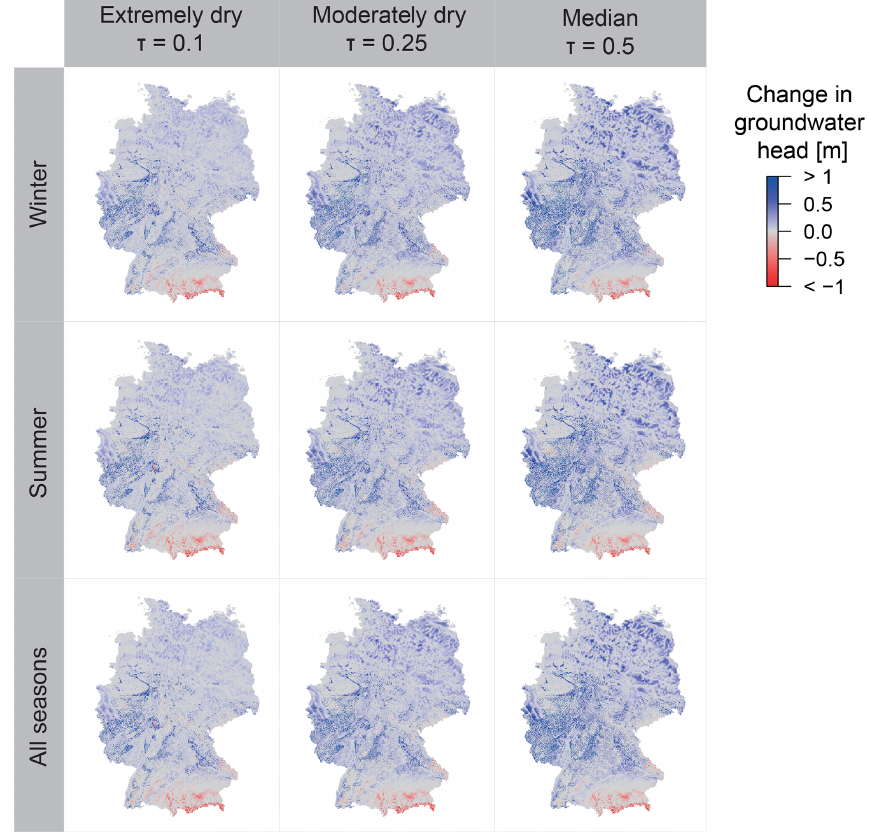
Figure 5. Groundwater head changes for S SHIFT in Germany for selected drought thresholds (columns) for different seasons (rows) for a shift of